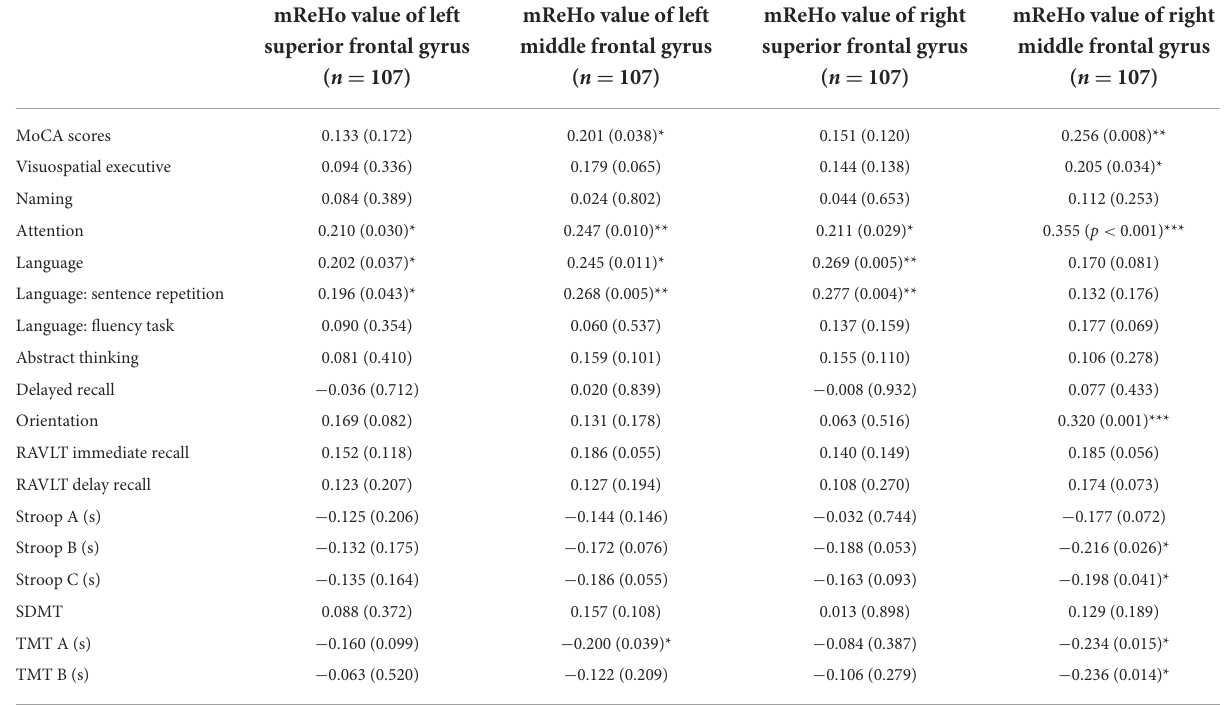
TABLE 4 Correlation analysis between mReHo and cognitive scale in patients with left acoustic neuroma.